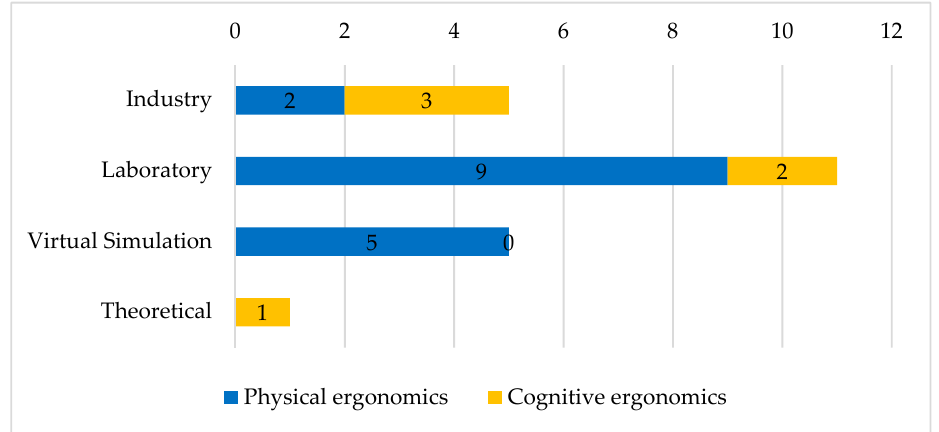
Figure 4. Articles distribution per context (industry, laboratory, virtual simulation, or theoretical) related to the ergonomics domain (physical or cognitive).